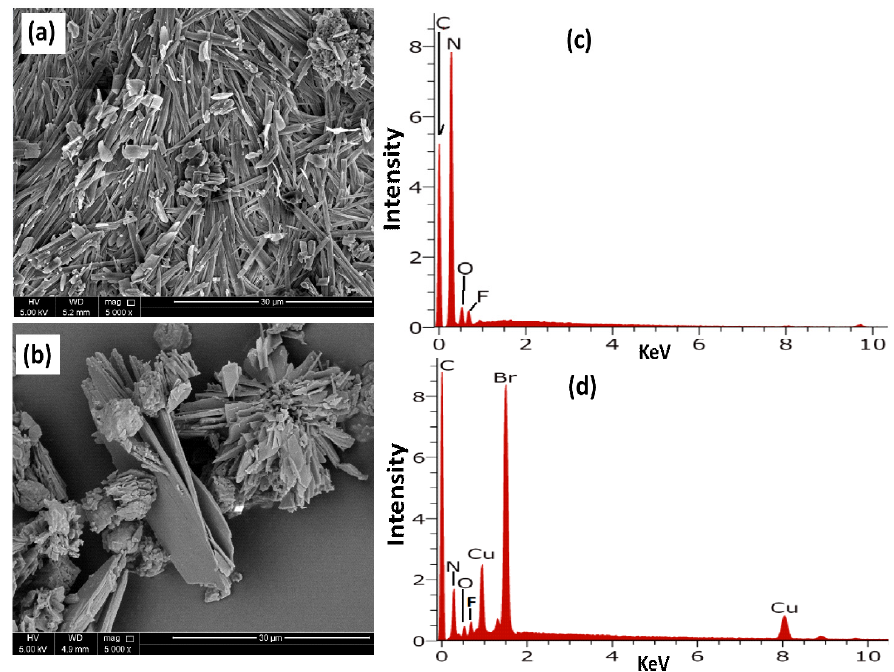
Figure 3. SEM images for ligand ( a ) and complex 2 ( b ); EDX for ligand ( c ) and complex 2 ( d